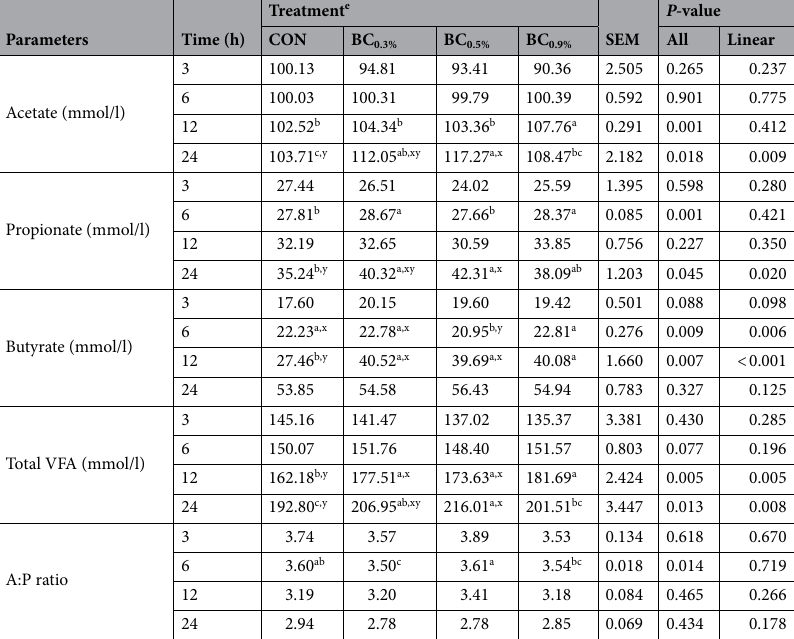
Table 2. Volatile fatty acid production during in vitro rumen fermentation incubated at 3, 6, 12, and 24 h. SEM, standard error of the mean. e CON (no buffer added); BC 0.3% (0.3% buffer); BC 0.5% (0.5% buffer); BC 0.9% (0.9% buffer). a–c Means with different superscripts in a row differ significantly ( P < 0.05); x,y Means within a row indicate linear effect among CON, BC 0.3% , and BC 0.5% ( P < 0.05).